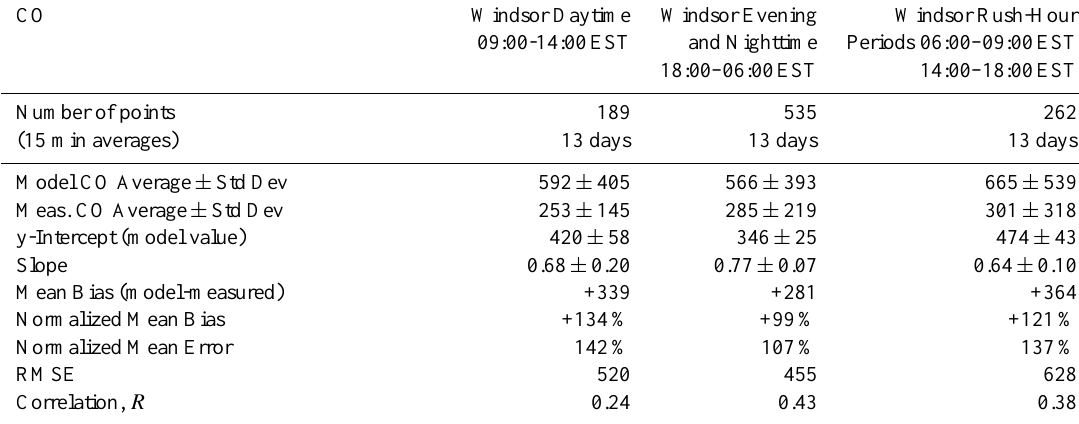
Table 5. AURAMS CO model performance statistics for the 2.5-km grid for the urban Windsor site (mixing ratios in ppbv). CO